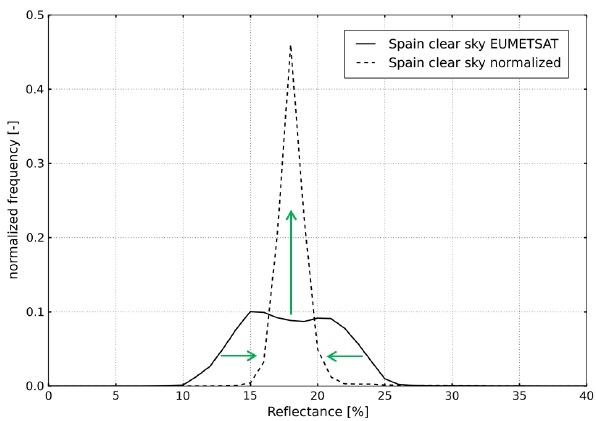
Fig. 5. Normalized frequency distribution of clear-sky HRV re- Fig.5. NormalizedfrequencydistributionofclearskyHRVreflectancesoverSpainobservedbyMSGSEVIRI flectances over Spain observed by MSG SEVIRI on 15 July 2011. on 15 July 2011. The solid line is the distribution of clear sky reflectances identified by the EUMETSAT cloud The solid line is the distribution of clear-sky reflectances identified mask. The dotted line is the histogram of the normalized clear sky reflectance after subtraction of the clear sky by the EUMETSAT cloud mask. The dotted line is the histogram of composite anomaly map. The green arrows symbolize the reduction of spatial variability. the normalized clear-sky reflectance after subtraction of the clear- sky composite anomaly map. The green arrows symbolize the re- duction of spatial